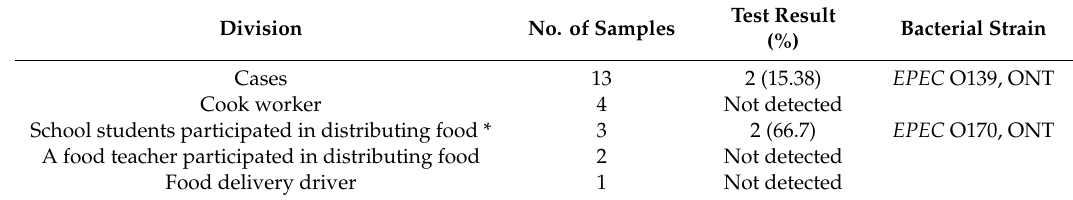
Table 1. Laboratory test results of the human specimens.